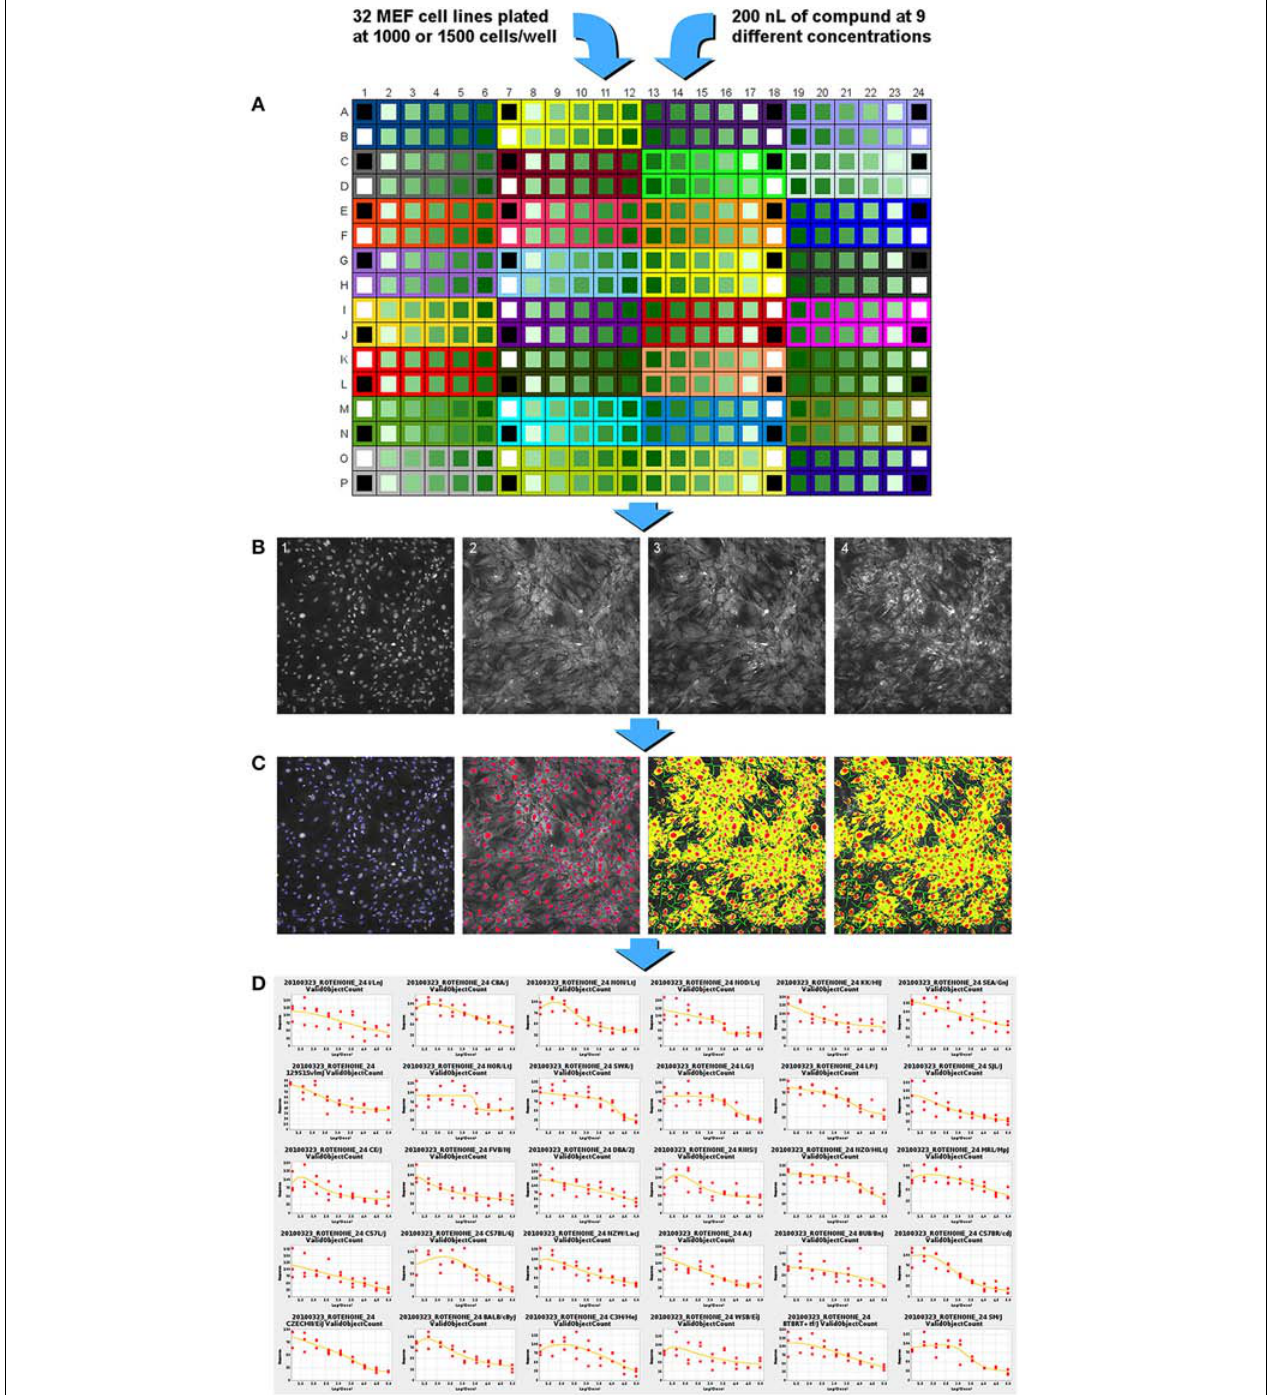
FIGURE 1 | Experimental flow chart for high-content screening of the MEF lines in concentration-response format across 65 diverse compounds. (A) MEF cells from 32 inbred strains are plated into a single 384 well plate. Compound is added from a master plate using a 200nl pin-tool resulting in 9 concentrations of compound (15nM to 100 μ M for most chemicals, Data Sheet 1 contains the different ranges used), one positive control compound and two wells of negative control, DMSO control, and no treatment control. (B) Cell staining reagents are added,